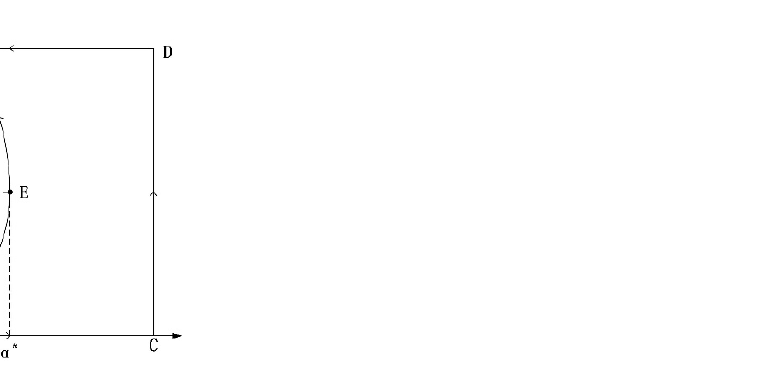
Figure 1. Scenario 1 evolutionary path between local government and coal-related enterprises.